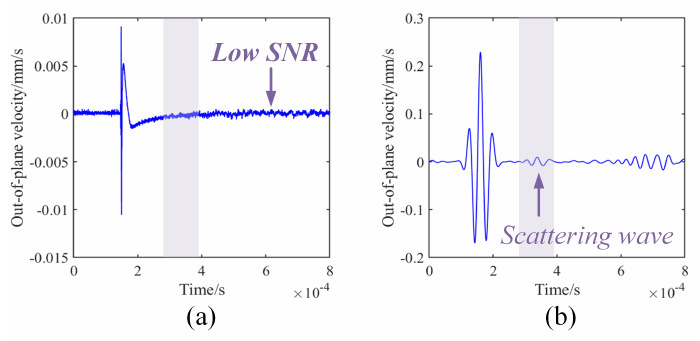
Figure 3. Limitation of low signal-to-noise ratio (SNR) of laser ultrasonic Lamb wave. ( a ) Scat- tered waves are submerged. ( b ) Scattering waves are highlighted after the continuous wavelet transform